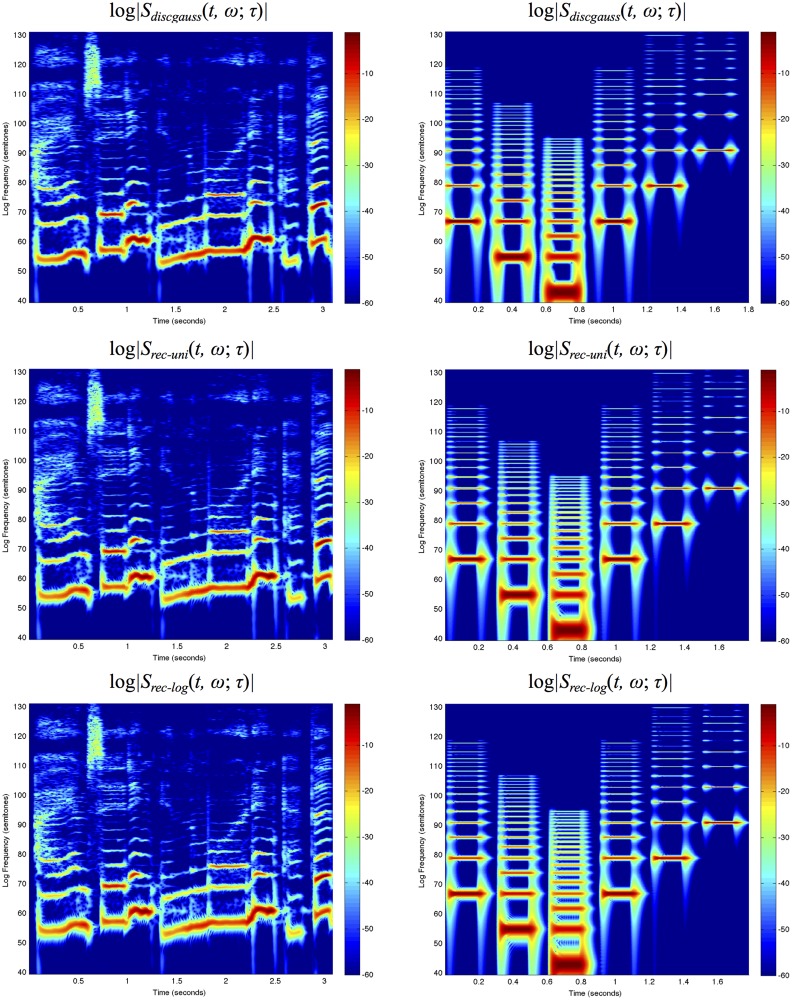

Spectrograms with a fixed temporal window scale
σt=τ=20ms computed using different temporal scale-space concepts for (left column) the first 3 seconds of “Tom’s diner” by Suzanne Vega with the lyrics “I am sitting in the morning at the …” and (right column) a synthetic signal containing harmonic spectra with different fundamental frequencies over a logarithmic frequency scale from 80 Hz to 16 kHz using 48 frequency levels per octave: (top row) the discrete analogue of the Gaussian kernel, (middle row) a cascade of seven time-causal recursive filters having a uniform distribution of the temporal scale levels and (bottom row) a cascade of seven time-causal recursive filters having a logarithmic distribution of the temporal scale levels with c=2.The vertical axis shows the logarithmic frequency expressed in semitones with 69 corresponding to the tone A4 (440 Hz). Notice that while the different types of spectrograms largely capture similar types of spectro-temporal structures, there is a significant difference in temporal delay and temporal response characteristics between the non-causal and the time-causal spectrograms.